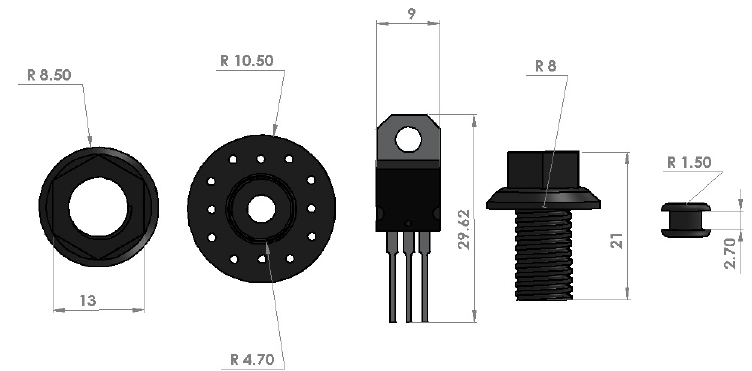
Figure 9. Objects used for the experiments including sizes in millimeters from left: nut, plastic servo head, IC, bolt, rubber